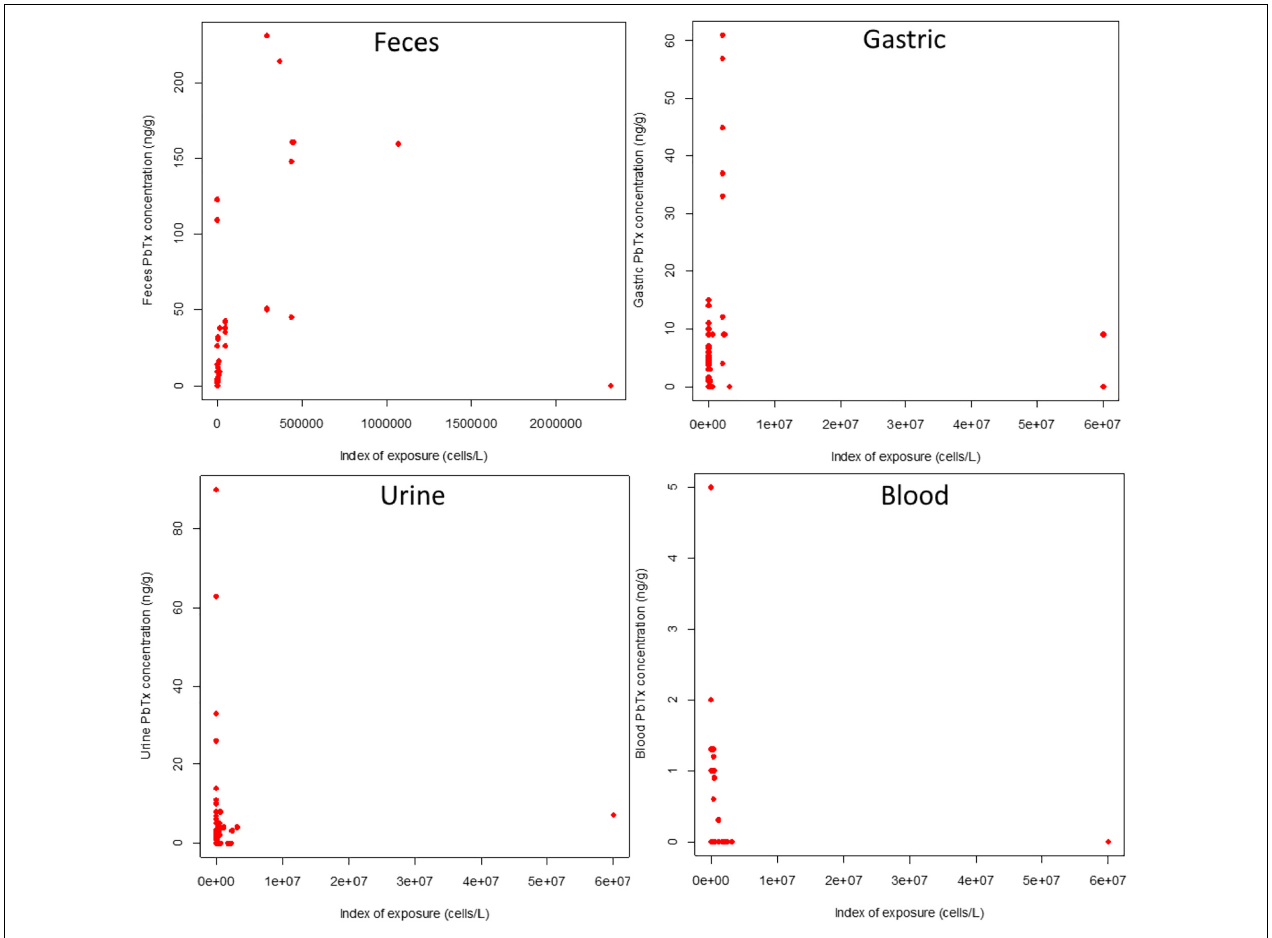
FIGURE 2 | PbTx concentration vs. index of